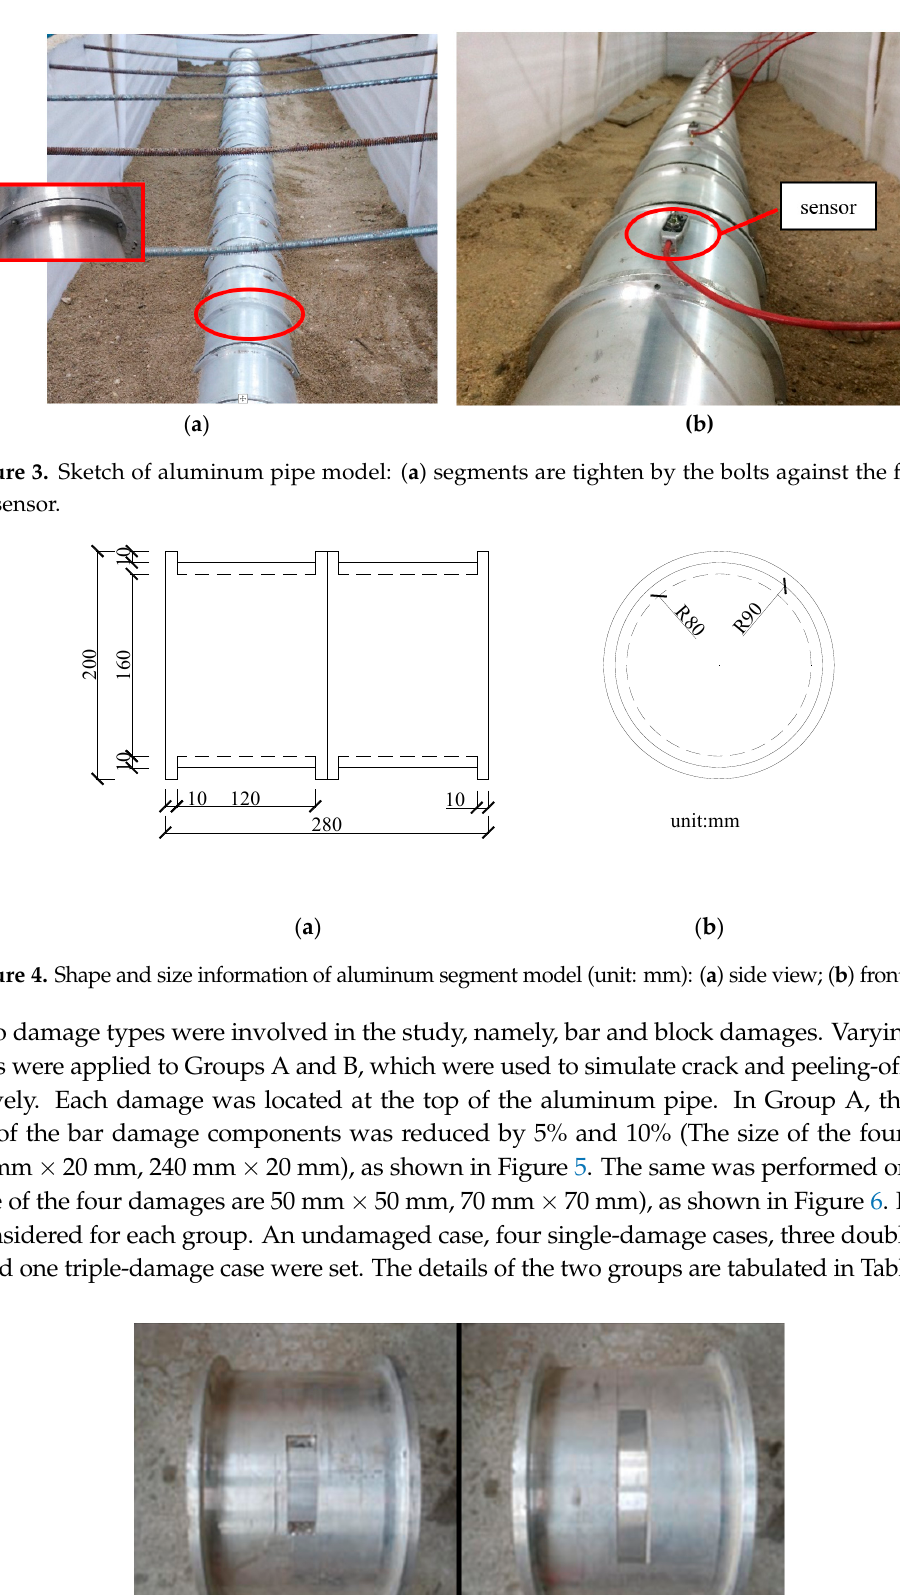
( b ) Figure 6. Block damage scenarios: ( a ) 5% damage; and, ( b ) 10% damage. Table 2. Damage cases of Groups A and B considered in experimental verification. Label